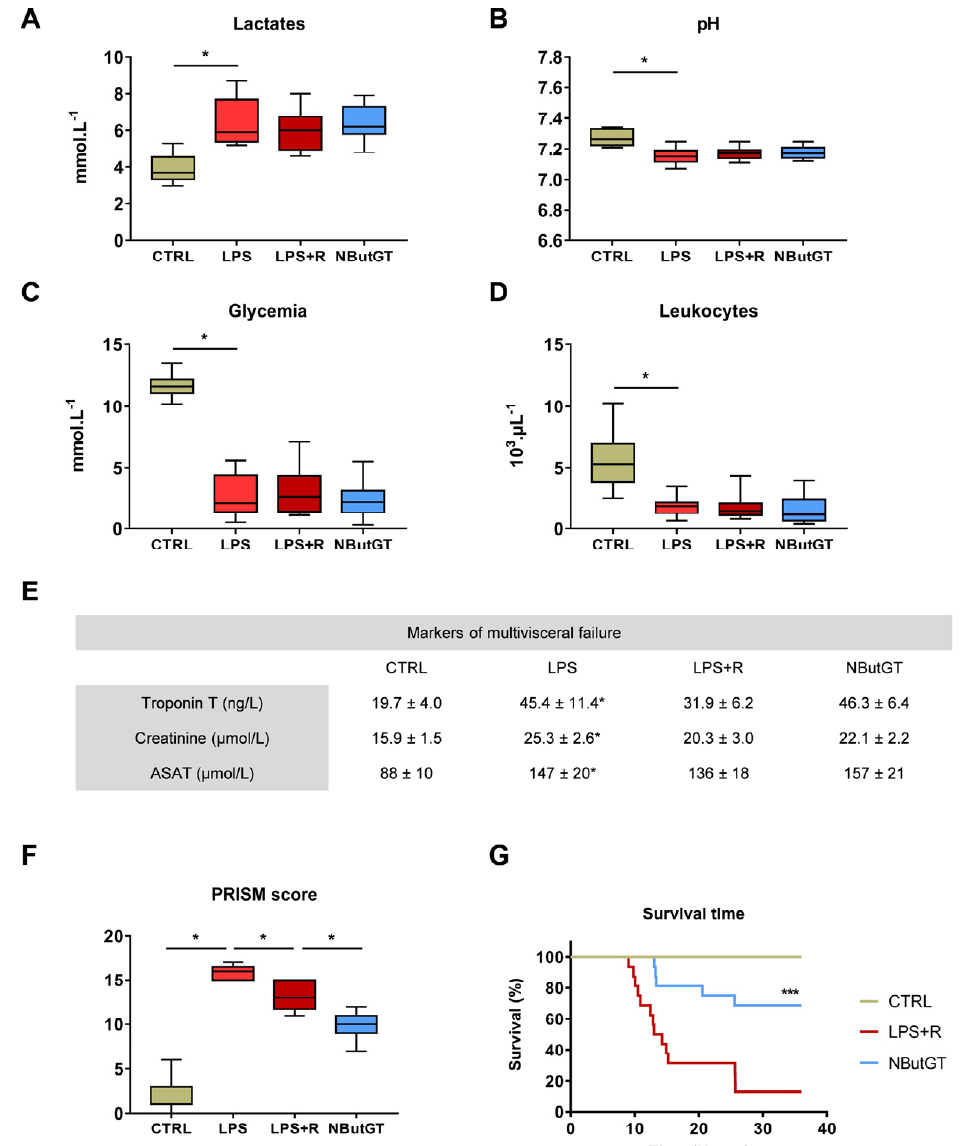
Figure 3. Impact of endotoxemic shock and O -GlcNAc stimulation on circulating parameters, adapted PRISM score and survival time. To study the impact of endotoxemic shock and treatments, the levels of lactates ( A ), pH ( B ), glycemia ( C ), leukocytes ( D ) and markers of organ function (Troponin T, Creatinine and Aspartate transaminase (ASAT) ( E ) were measured in venous blood collected from rats anesthetized with isoflurane. Statistical significance was assessed by Kruskal–Wallis test with uncorrected Dunn’s post-test (*: p < 0.05, relative to CTRL). ( F ) Adapted PRISM score was realized with behavior score, physiological and circulating parameters. Statistical significance was assessed by Kruskal–Wallis test with uncorrected Dunn’s post-test (*: p < 0.05). n = 5–7. ( G ) Survival analysis is presented using a Kaplan–Meyer curve. Statistical significance was assessed by Mantel–Cox test (***: p < 0.001, relative to LPS+R). n = 16 per group. CTRL: control group, LPS: i.v. injection of LPS (20 mg/kg), LPS+R: subcutaneous administration of 10 mL/kg of NaCl 0.9%, NButGT: resuscitation supplemented with NButGT (10